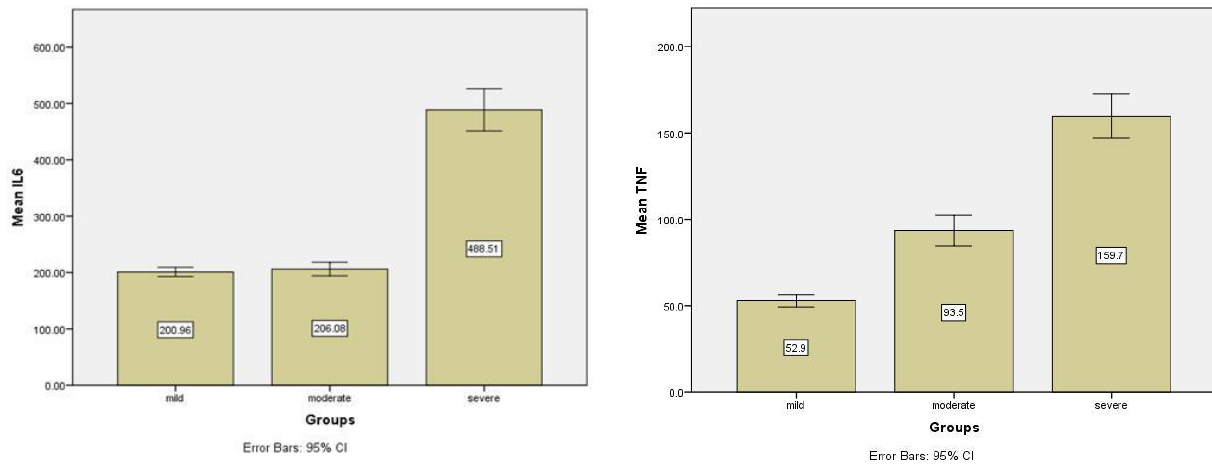
Figure 1. Mean serum levels of: a) IL-6 and b) TNF-α in sever- versus mild- and moderate